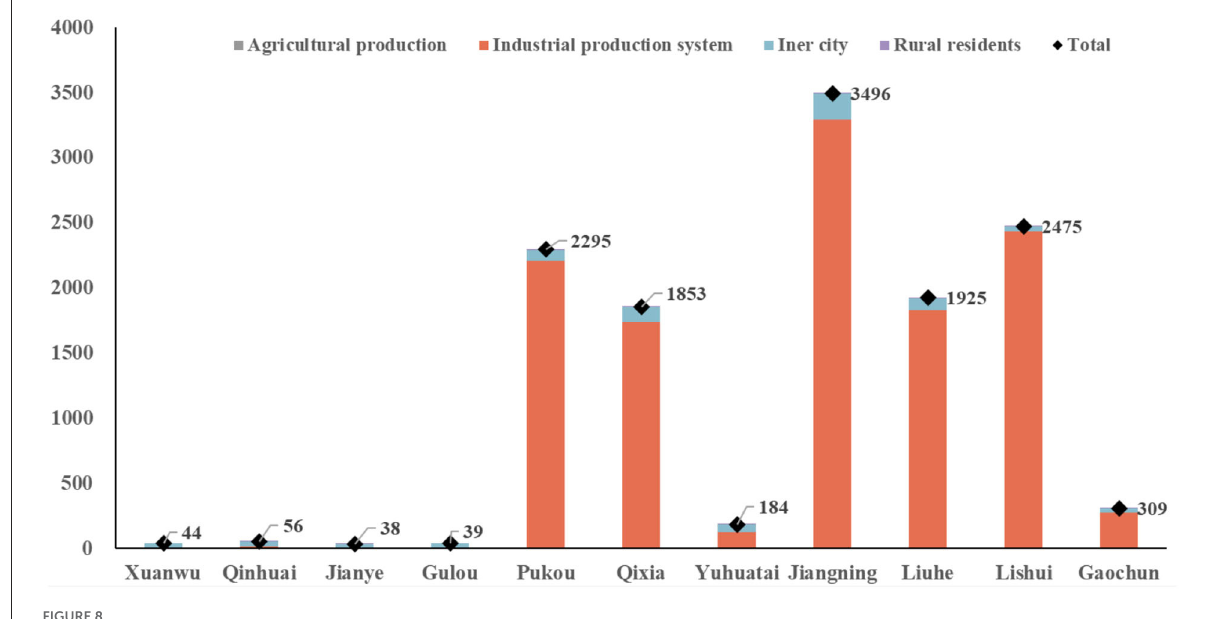
FIGURE8 The carbon emissions of sub-regions and structures in Nanjing.